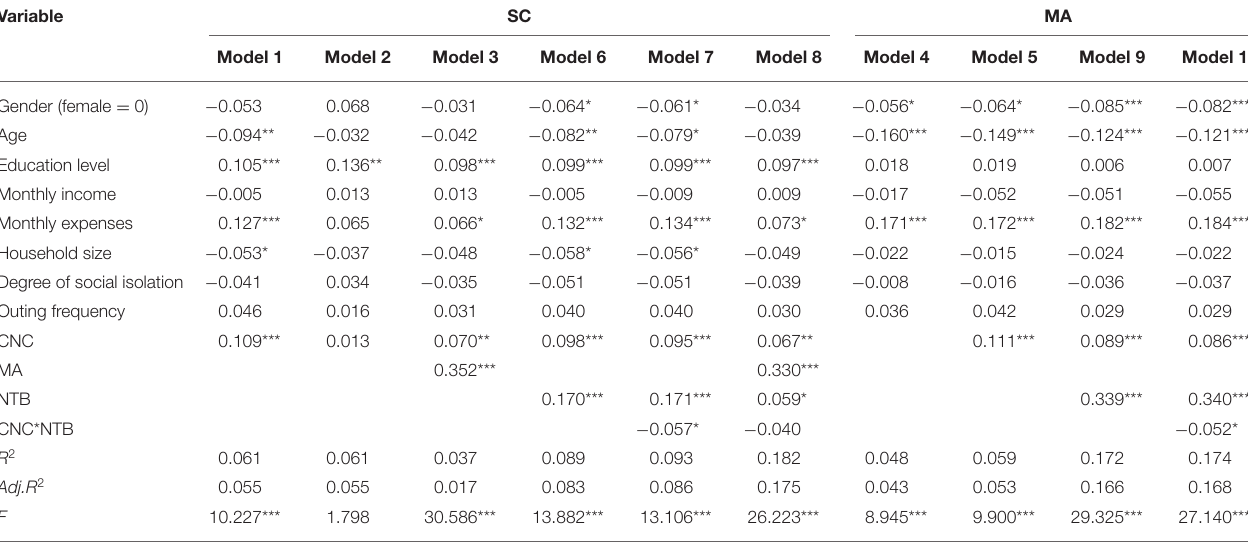
TABLE 3 | The result of stepwise regression analysis ( N = 1,548).